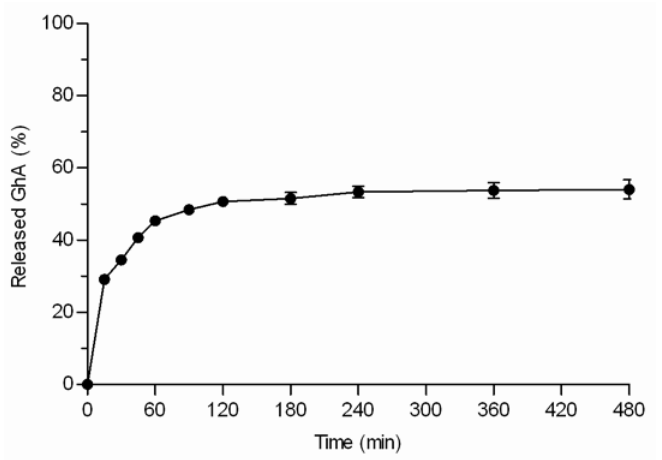
Figure 5. Ghrelin antagonist release from THCPSi microparticles as assessed by the centrifuge method. Mean ± SD values are shown (n =